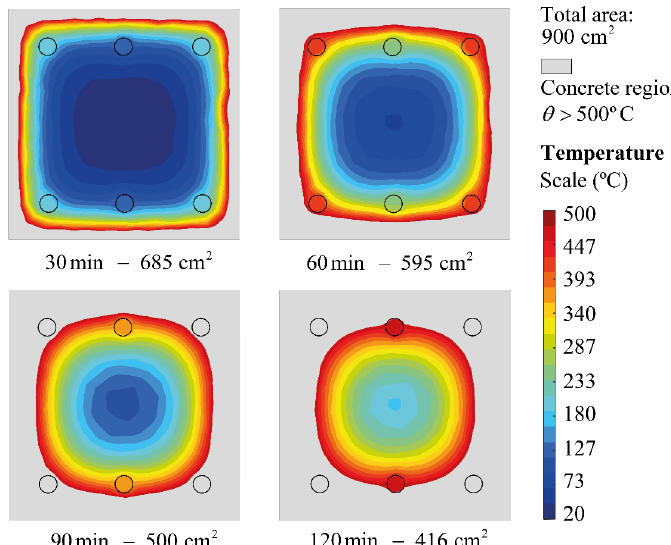
Figure 9. Representation of the internal concrete region below 500ºC